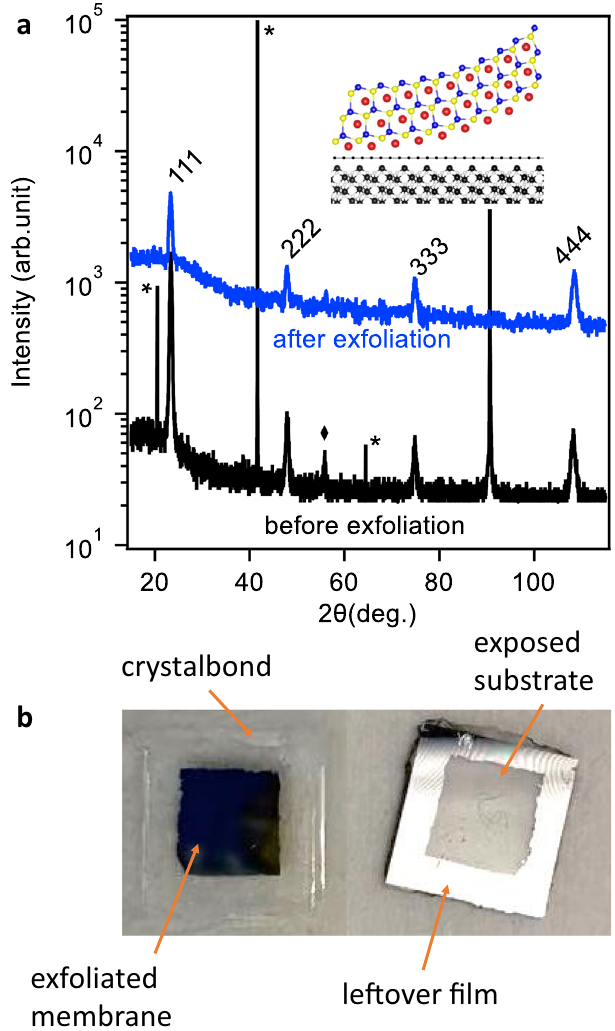
Fig. 4 Crystallography and exfoliation of fl at GdPtSb membranes. a XRD θ – 2 θ (Cu K α ) scans before exfoliation (black) and after exfoliation (blue). Sapphire substrate re fl ections are marked by asterisks. In addition to the with a diamond. b Photos of GdPtSb membrane exfoliation from a 1 × 1 cm 2 substrate. The left image shows a fl at exfoliated membrane bonded to a glass slide. The right image shows the substrate side after exfoliation. In the region that had been covered with graphene (~6 × 6 mm 2 square at center), the GdPtSb membrane has been exfoliated to yield a transparent sapphire substrate. In the region not covered by graphene, the GdPtSb fi lm remains adhered to the